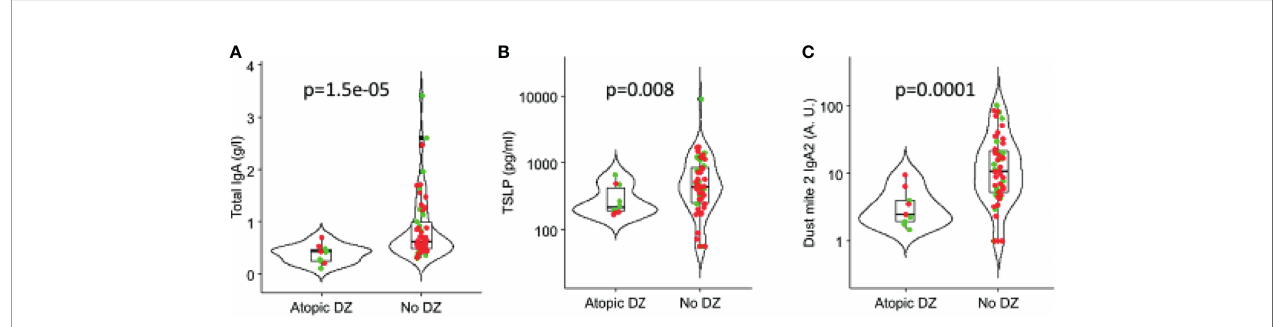
FIGURE 7 | Association of IgA and cytokines in human milk with atopic outcomes in children in the fi rst 3 years of life. (A) Total IgA, (B) TSLP (thymic stromal lymphopoietin), and (C) Dust mite 2 IgA2. Red: OOM. Green: